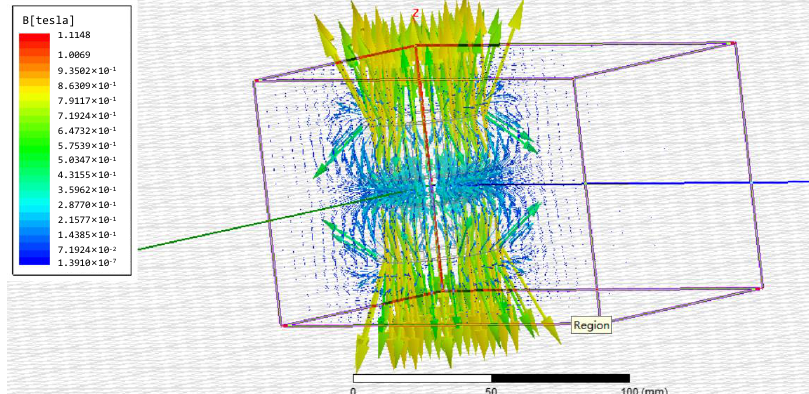
Figure 7. Actuator simulation model diagram.